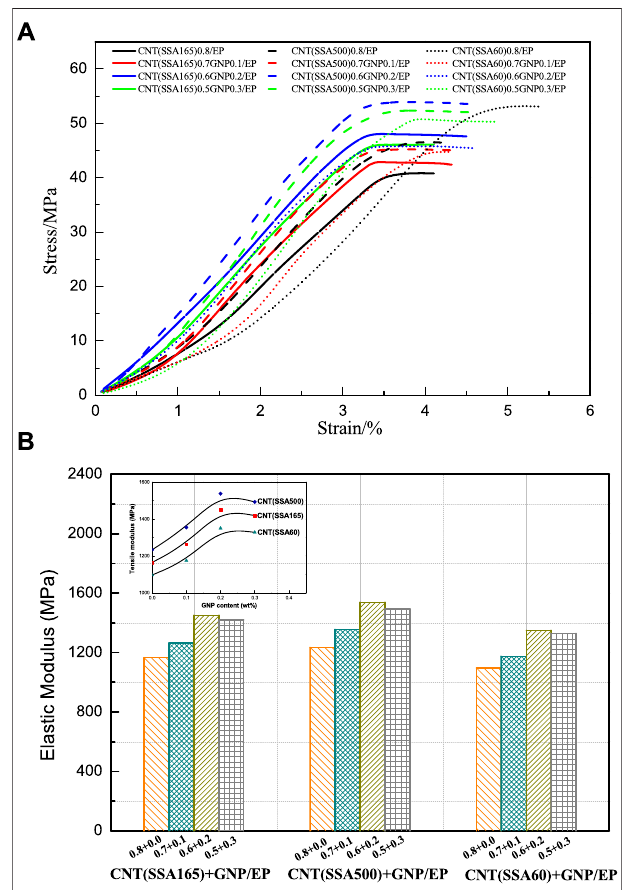
FIGURE 10 | Tensile properties of the epoxy composites with 0.8 wt% carbon fi llers. (A) strain-stress curves of the composites, (B) elasticity modulus of the